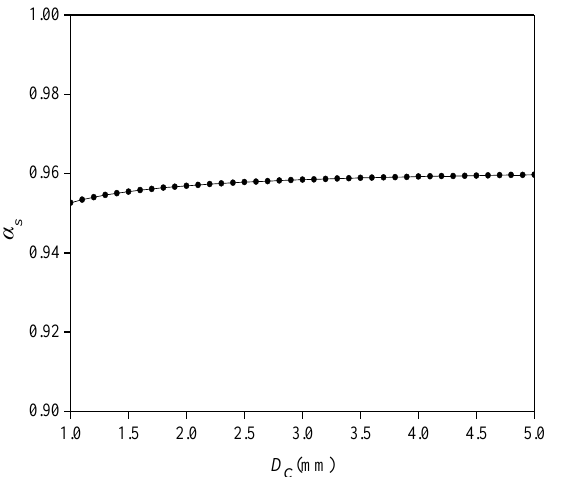
Figure 5. Relationship between width of cemented layer and average strain-transfer coefficient.